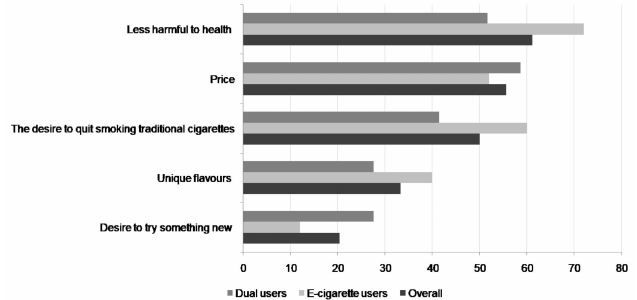
Figure 1. Motivations for e-cigarette